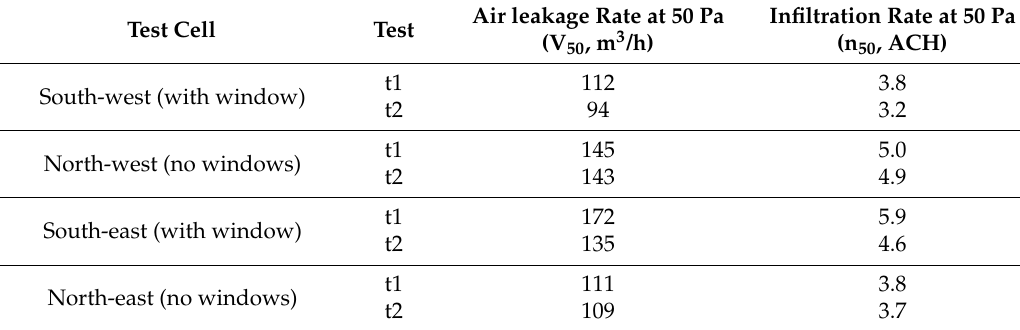
Table 6. Test cell infiltration rates.